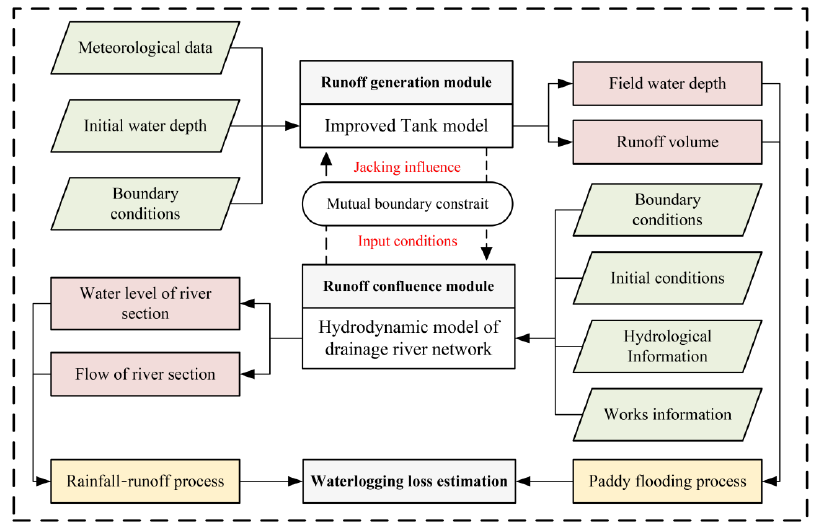
Figure 2. Framework and internal relationships between the modules of the Waterlogging Process Model. Water 2023 , 15 , 192